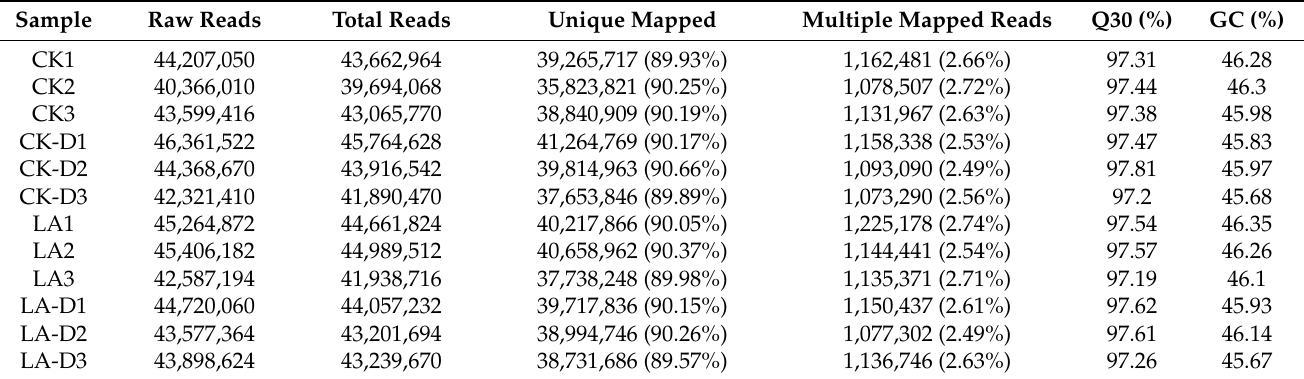
Table 1. Summary of RNA-Seq reads mapped to the peach genome.